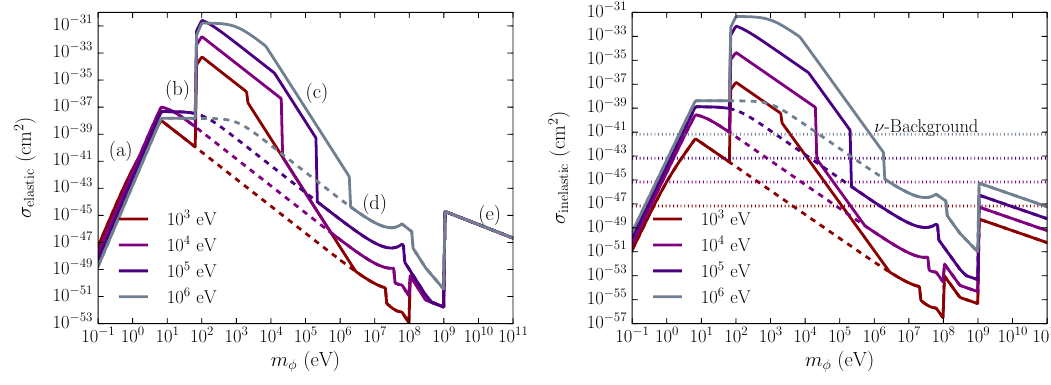
Figure 3 . Left: limits on the dark matter-nucleon elastic cross-section as a function of mediator mass for various dark matter masses. The dashed (solid) lines show the cross-section with (without) a future cosmological constraint that excludes (cid:1) N e(cid:11) = 0 : 09. The regions indicated by labels (a-e) are primarily constrained by (a) long range forces (b) SN1987a (c) meson decays (d) thermalization of mediator (because of mediator decay to dark matter) (e) mediator decay to dark matter (limit on (cid:21) ). If a constraint on N e(cid:11) forbids thermalization of the mediator above the QCD phase transition, then the trapping window allowed by SN1987A is excluded and the dashed line shows the region (c) is eliminated. Right: limits on the dark matter-nucleon inelastic cross-section as a function of mediator mass for various dark matter masses, using A = 130. The dashed (solid) lines show the cross-section with (without) the constraint from excluding (cid:1) N e(cid:11) = 0 : 09 in the CMB. The dotted lines show the neutrino background expected for the same momentum transfer as a dark matter part of the appropriate mass. Note that a future measurement excluding (cid:1) N e(cid:11) = 0 : 09 would exclude a large fraction of the viable parameter space above the associated neutrino